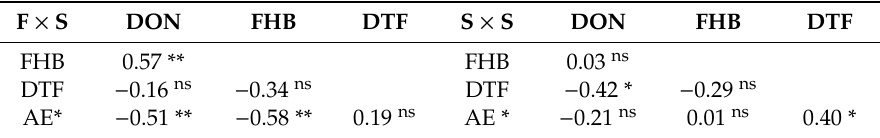
Table 4. Pearson’s correlation analysis among di ff erent agronomic and Fusarium head blight (FHB) traits from spawn-inoculated field experiments using selected RILs from F × S and S × S populations. Data from the recombinant inbred lines only was used for analysis. Anther extrusion (AE*) was calculated from anther retention (AR) using the formula AE = 2.71 (3-AR) . F × S: Fiia by Stormogul cross, S × S: Svea by Stormogul cross, DON: Deoxynivalenol content, FHB: field Fusarium head blight